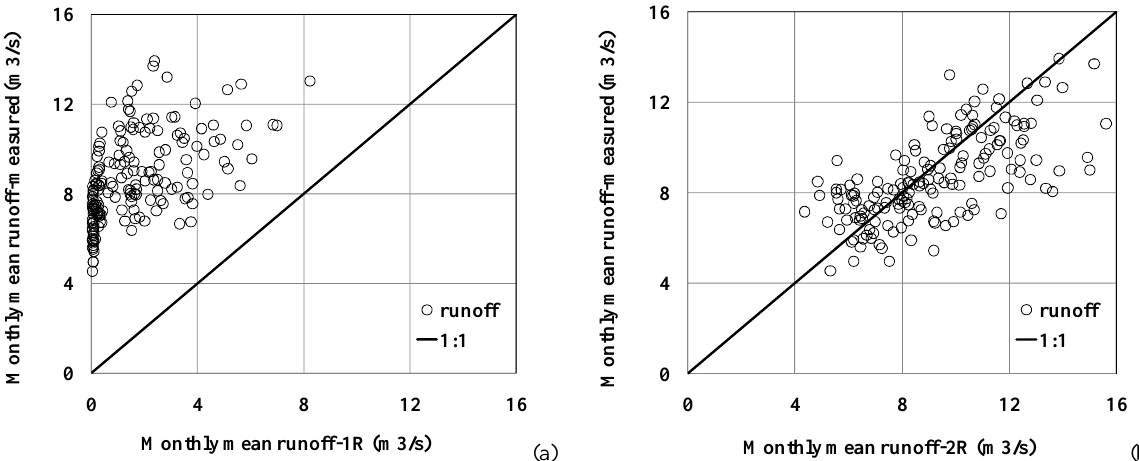
Fig. 6. Comparison of the simulated and measured monthly averaged low-flow discharge rates. (a) The one-reservoir approach was used; (b) the two-reservoir approach was used.